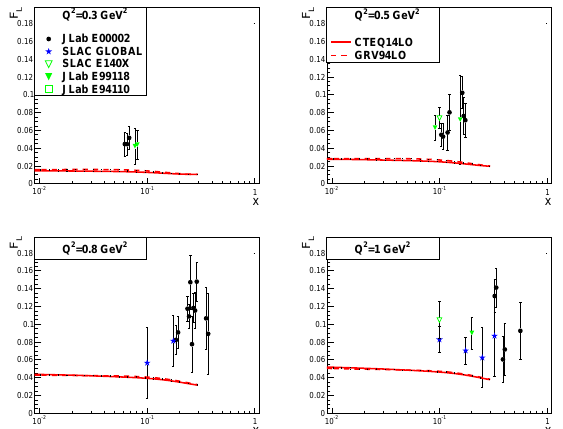
Figure 3: The results from the model for F GRV94LO compared to the JLAB [ 5 ] and SLAC [ 6,7 ]